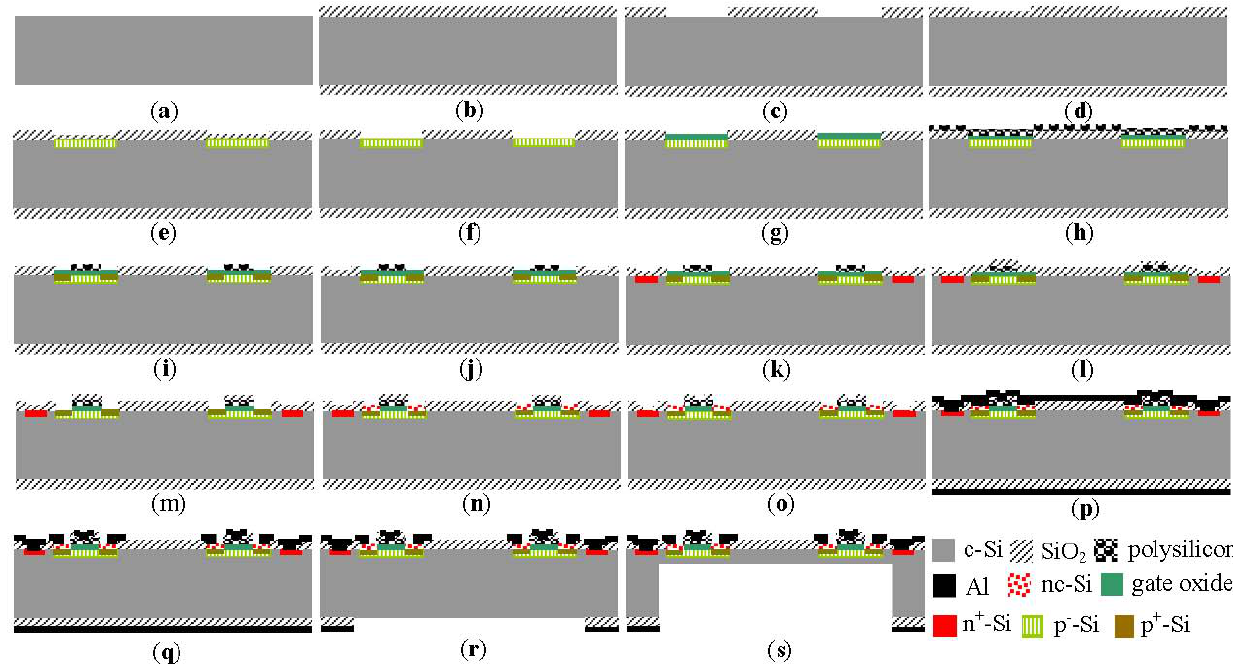
Figure 4. Fabrication technology process of the nc-Si/c-Si heterojunction MOSFETs pressure sensor chip.